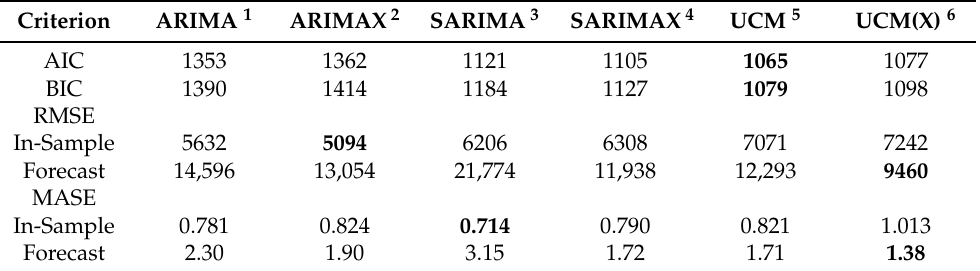
Table 4. Overview of in-sample predictions and forecasted results of ARIMA(X), SARIMA(X) and UCM(X) models. The baseline UCM with Feature Set 5 achieves the best forecast